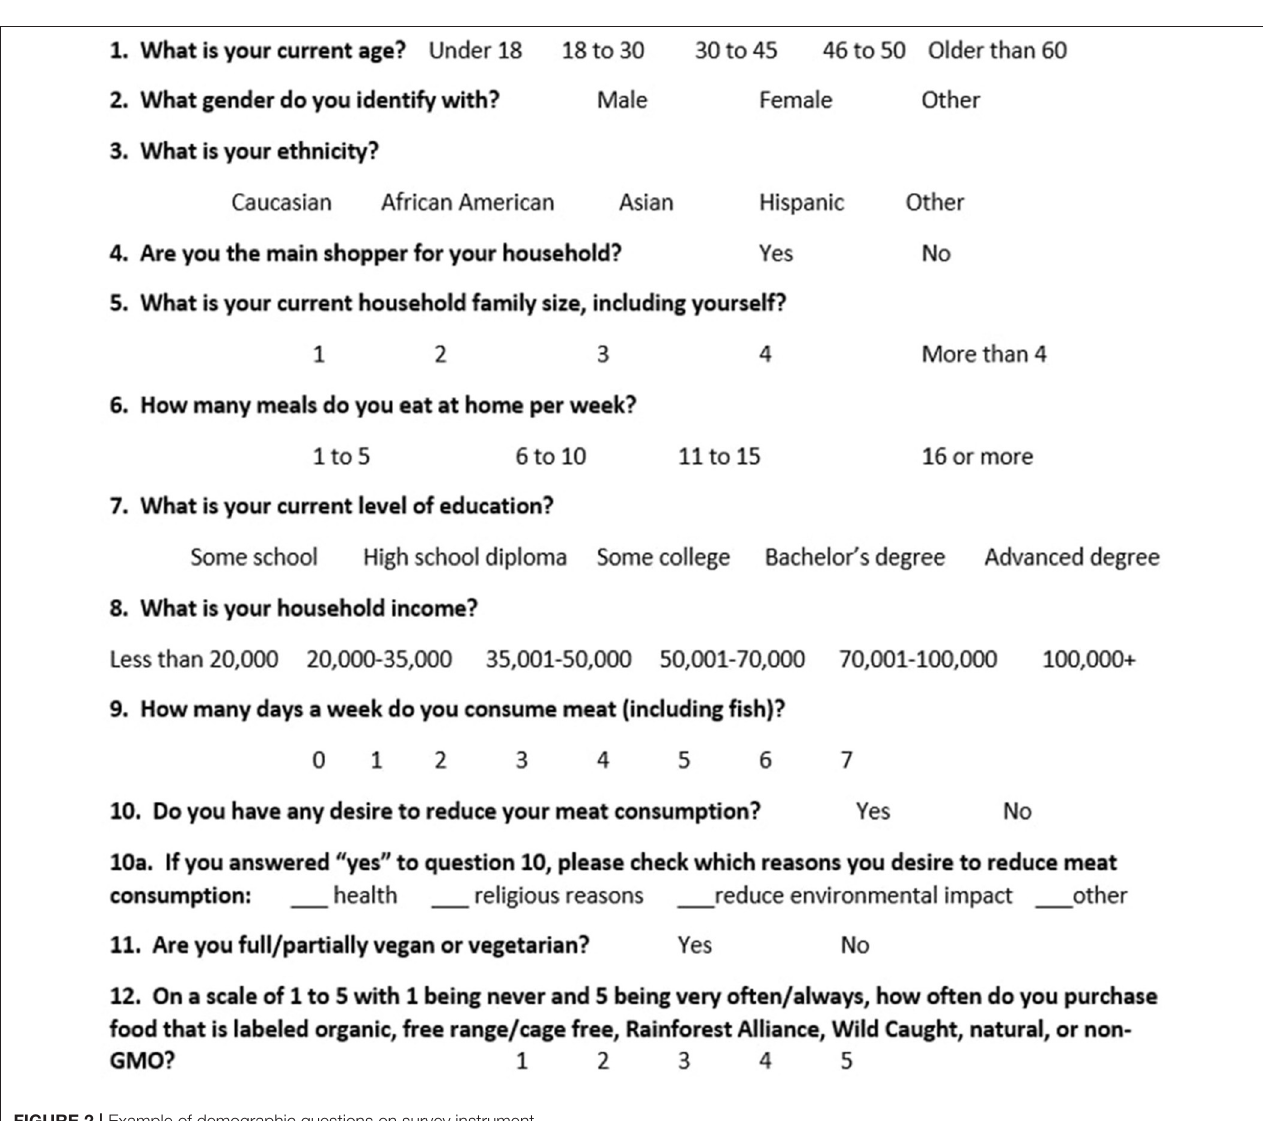
FIGURE 2 | Example of demographic questions on survey